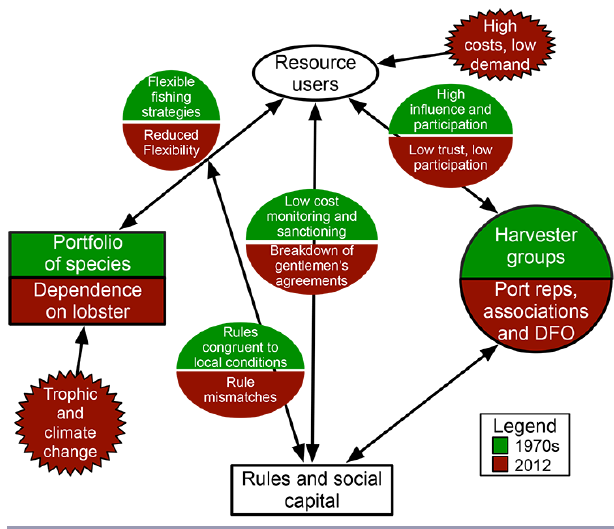
Fig. 3 . Comparison of the Port Lameron social-ecological system in the 1970s (Davis 1984 a , Ostrom 1990) and in